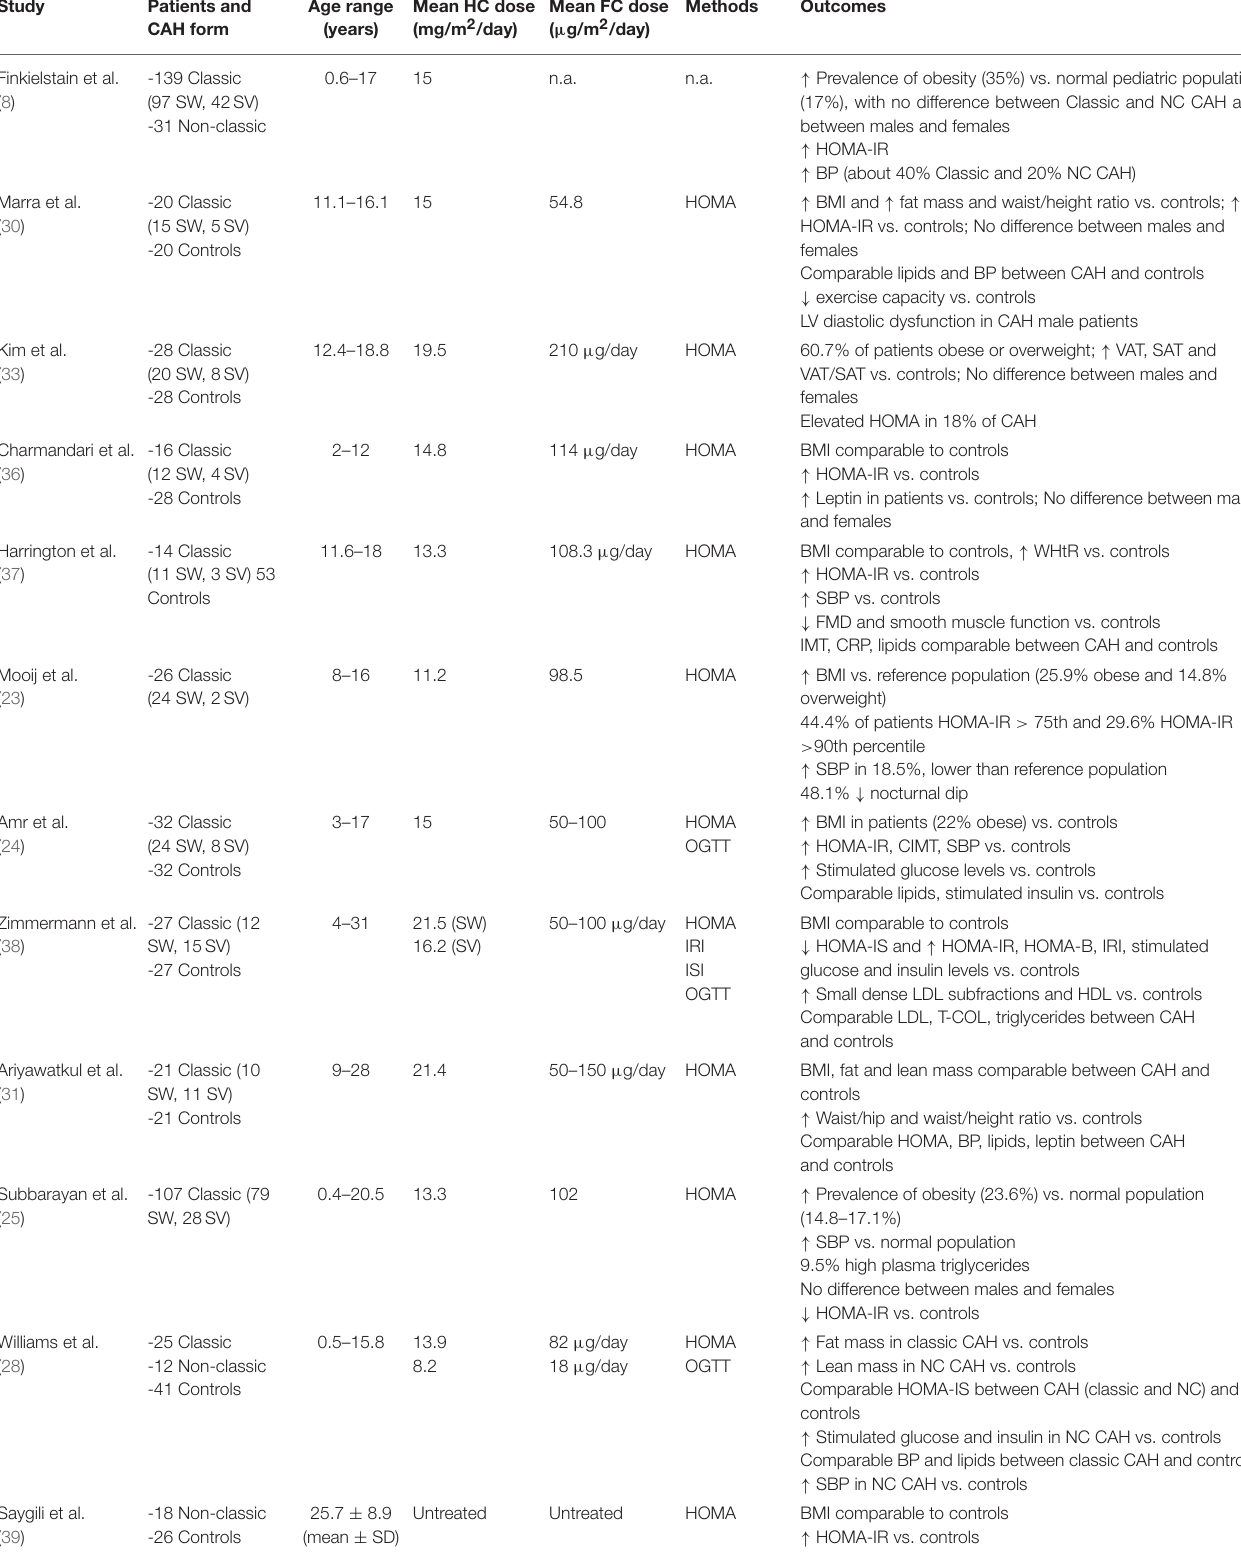
TABLE 2 | Summary of main studies addressing insulin-sensitivity in CAH patients. Study